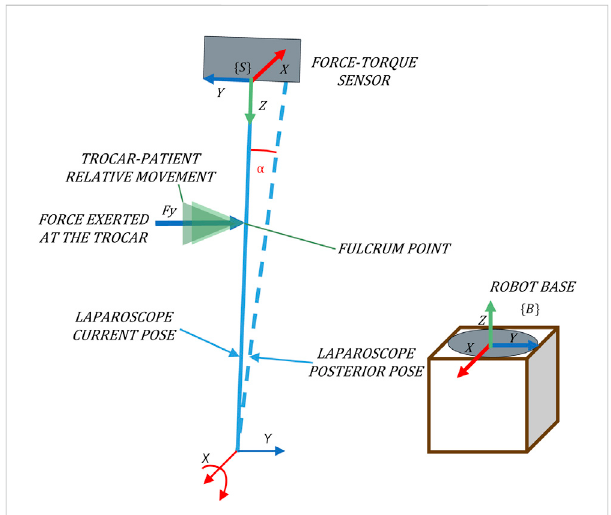
FIGURE 2 Pivoting movement as a consequence of forces exerted in the direction of the Y -axis of